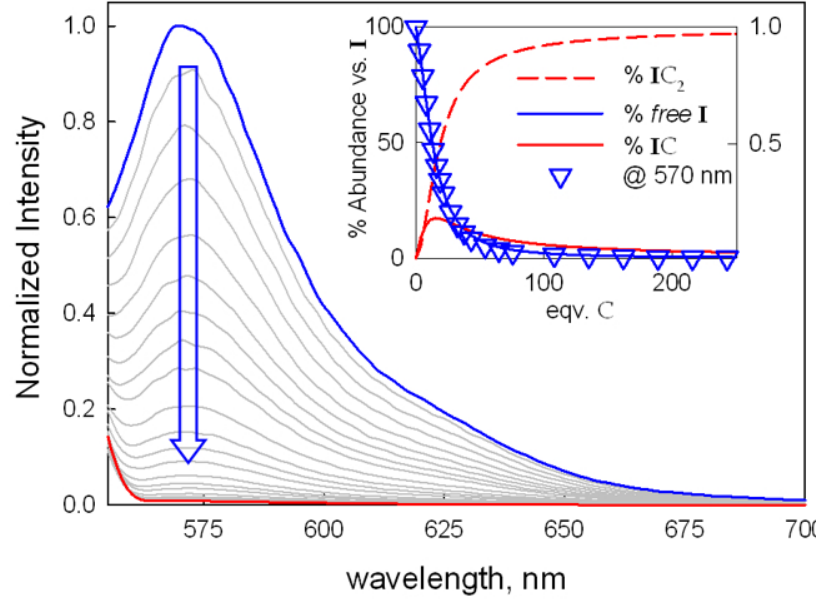
Figure 3. Normalized emission spectra taken upon titration of 6-TAMRA, I (0.25 µ M, λ exc = 548 nm) with [Cu 2 L](CF 3 SO 3 ) 4 (C) in H 2 O:CH 3 CN 1:4 at pH 7 (0.02 M HEPES buffer). The inset shows the titration profile as the normalized intensity at 570 nm vs. eqv. of the added complex, with the superimposed distribution diagram of the indicator containing species (I, 6-TAMRA; C, [Cu 2 L] 4+ ; IC and IC 2 , 1:1 and 1:2 I:C adducts, respectively).